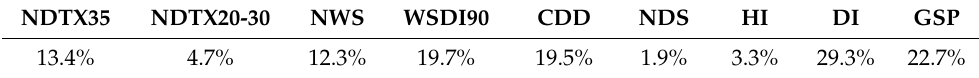
Table 1. Difference percentage between the linear and quantile mapping bias correction methods, using the root mean square error, for NDTX35 (Number of Days with maximum temperature, TX, above 35 ◦ C), NDTX20-30 (Number of Days with maximum temperature, TX, between 20 and 30 ◦ C), NWS (Number of Warm Spells), WSDI90 (Warm Spell Day Index above the 90th percentile), CDD (Consecutive Dry Days index), NDS (Number of Dry Spells), HI (Huglin Index), DI (Dryness Index), and GSP (Growing Season Precipitation). Statistically significant values at a confidence level of 99% are in bold. NDTX35 NDTX20-30 NWS WSDI90 CDD NDS HI DI GSP 13.4%